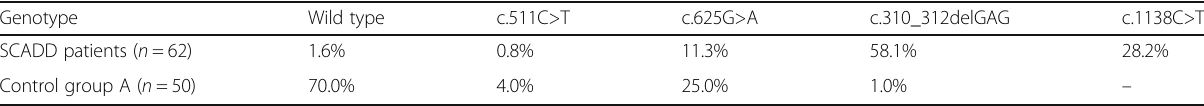
Table 3 The percentile representation of investigated genetic variants in the cohort of patients suspected of SCADD in comparison with control group A